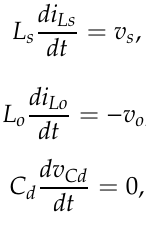
Figure 8. Equivalent bridgeless Cuk converter circuit in State 1 during negative half line cycle.